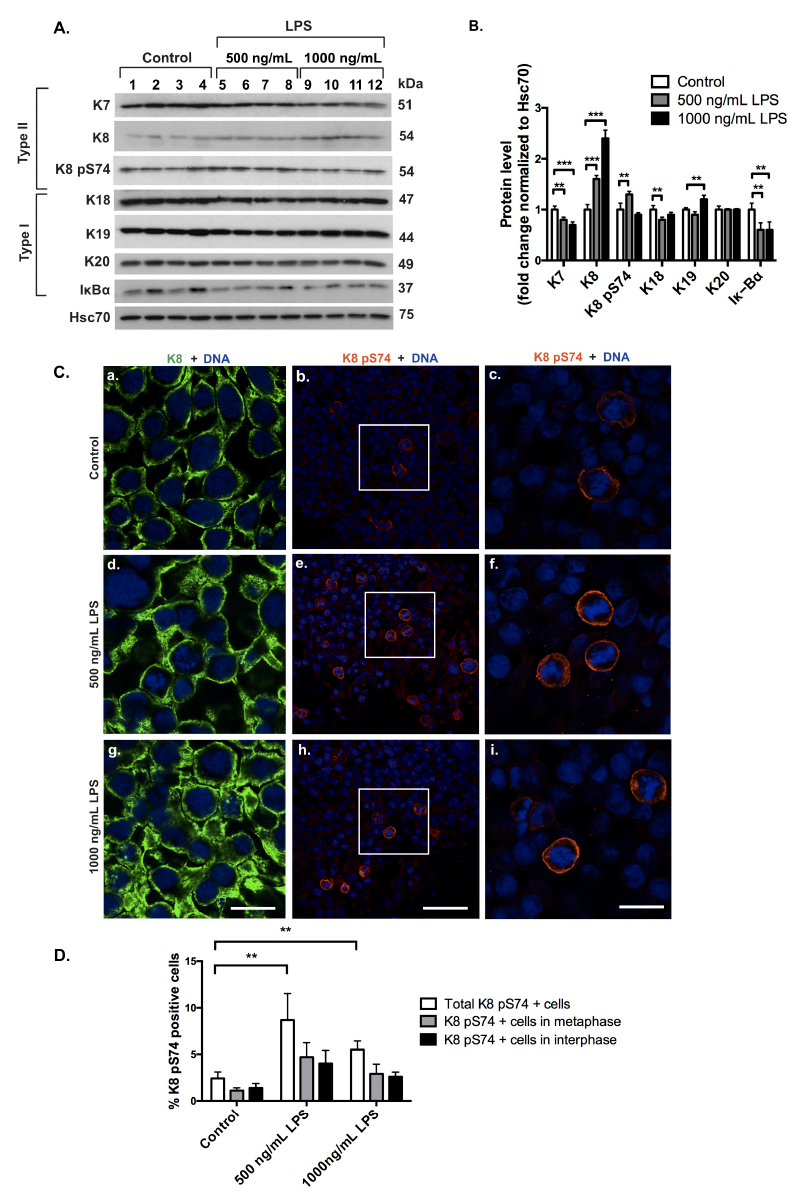
Figure 6. LPS, as a model for in vitro activation of inflammatory signaling pathways, upregulates K8 and K19 and increases phosphorylation of K8 at S74. Colorectal cancer HT-29 cells were treated with 500 ng/mL and 1000 ng/mL LPS for 48 h to induce inflammatory stress signaling. ( A , B ) LPS induced stress-activated inflammatory signaling, as seen by decreased levels of the NF- κ B inhibitor I κ B α , which was quantified by Western blotting and normalized to Hsc70. HT-29 cells showed an upregulation of the major colonic keratins K8 and K19 following treatment with 1000 ng/mL LPS. An increase in K8 pS74 was seen after treatment with 500 ng/mL LPS. ** p < 0.01, *** p < 0.001. ( C ) The upregulation of K8 (panels a, d and g; green) and the increase in K8 pS74 (panels b, e and h, and further magnified from white boxes to c, f and i, red) in response to LPS-treatment were confirmed by immunofluorescence staining. Nuclei (DNA) are shown in blue. Scale bar = 25 µ m for a, c, d, f, g and i. Scale bar = 75 µ m for b, e and h. ( D ) The increase in K8 pS74-positive cells was quantified, and showed a 6.3% increase in the amount of K8 pS74-positive cells after 500 ng/mL LPS-treatment compared to non-treated cells. For 1000 ng/mL LPS-treatment, the corresponding increase compared to non-treated cells was 3.1%. Numerical data are shown as average ± SD. Statistical significance for Western blot and immunofluorescence data was determined by